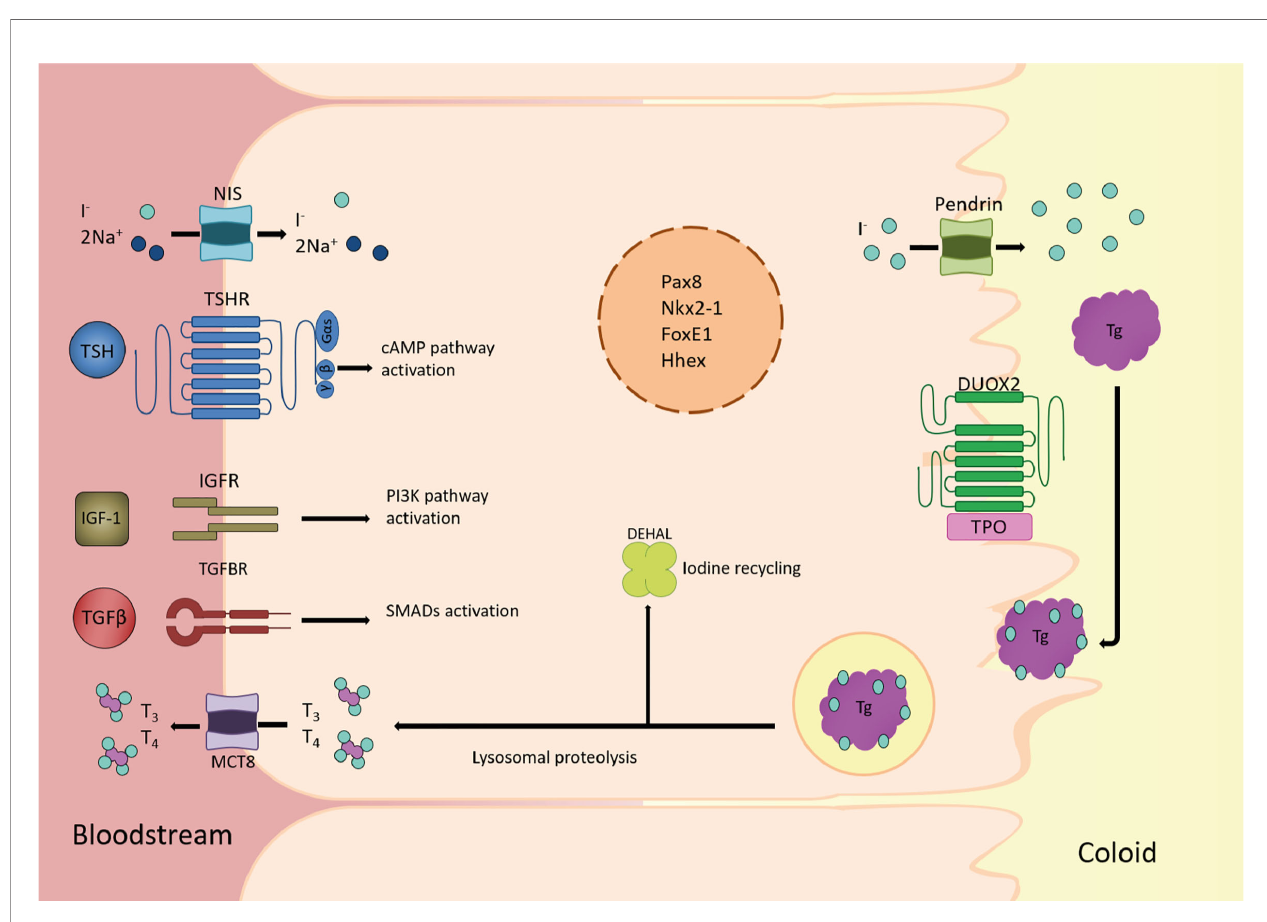
FIGURE 2 | Overview of the main players in thyroid follicular cell function. Schematic diagram of a thyroid follicular cell and the main proteins involved in the synthesis, storage, and release into bloodstream of the thyroid hormones triiodothyronine (T3) and thyroxine (T4). At the basolateral membrane, circulating iodide (I - ) is actively taken-up by the Nis symporter. It then passively diffuses to the apical membrane where it is actively transported to the lumen by Pendrin and other transporters. Once I - is oxidized by thyroid peroxidase (Tpo), using H 2 O 2 generated by the oxidase Duox2, tyrosine residues in thyroglobulin (Tg) are iodinated to form mono-iodotyrosine (MIT) and/or di-iodotyrosine (DIT), whose coupling yields thyroid hormones. Colloid droplets rich in Tg are endocytosed into the thyroid follicular cell, where Tg lysosomal proteolysis releases MIT, DIT, T4, and T3. Thyroid hormones are transported to circulation by the monocarboxylate transporter 8 (Mct8), whereas I - from MIT and DIT is recycled by the iodotyrosine deiodinase (Dehal1). All of these processes rely on the co-existence of the thyroid transcription factors Nkx2-1, Foxe1, Pax8 and Hhex, in the nucleus of the thyroid follicular cell, from where they regulate the expression of genes such as Slc5a5, Tpo, Tg and Tshr. Also, in the basolateral membrane, TSH, IGF1 and TGF b trigger the main pathways involved in adult maintenance of thyroid differentiation by cAMP, PI3K and SMAD activation,